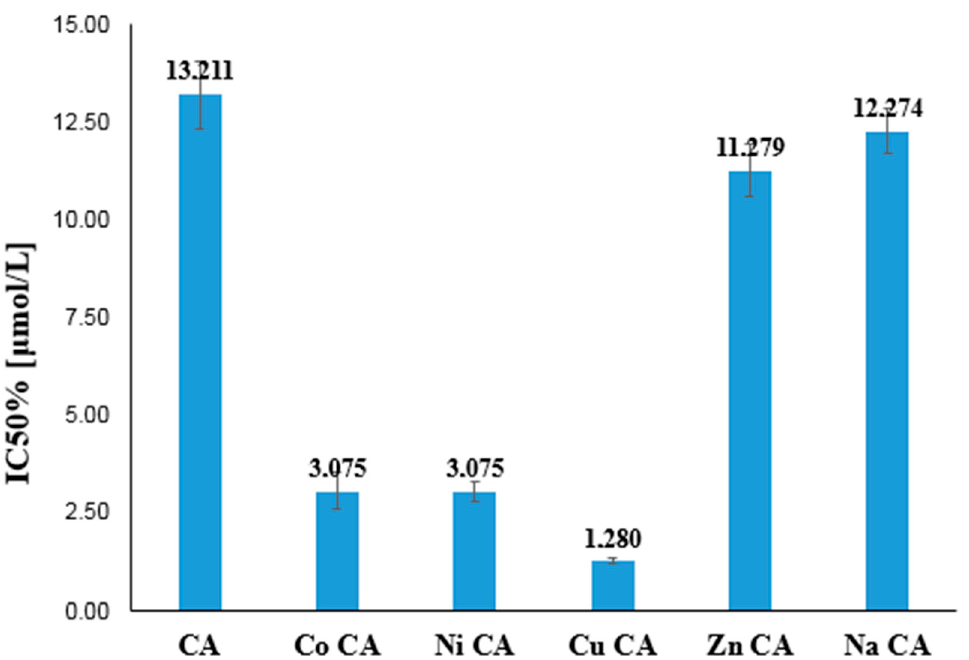
Figure 9. Antioxidant activity (measured using O 2 radical assay) of cichoric acid (CA) and its metal complexes.